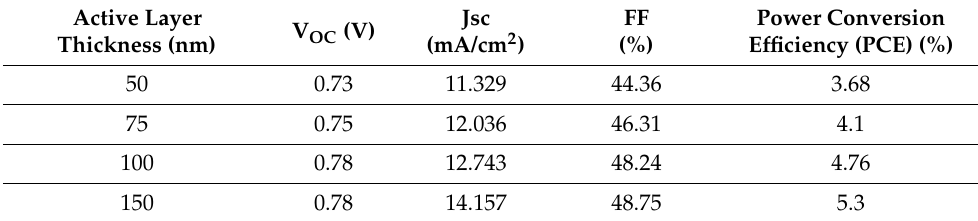
Table 1. Simulation results for different active layer thickness.